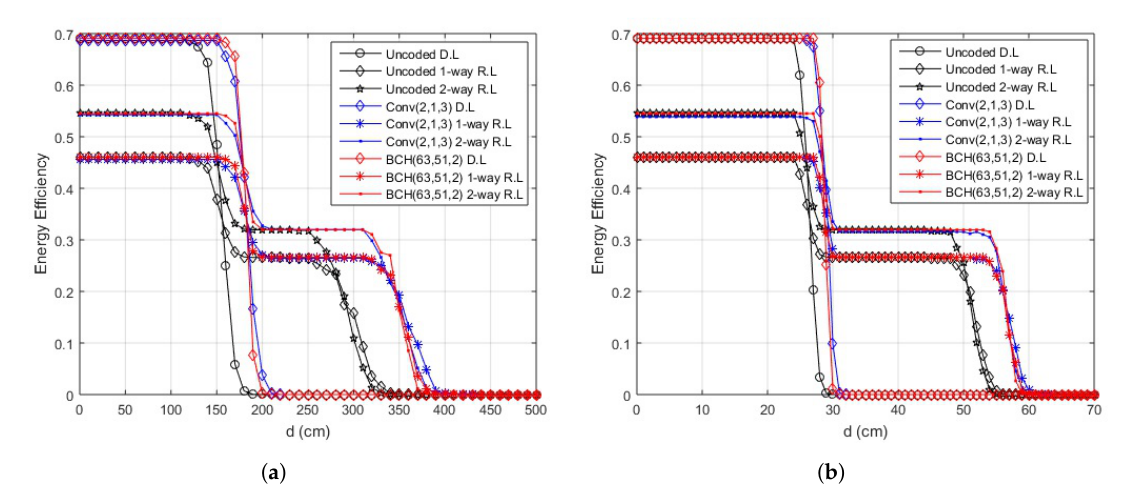
Figure 15. Energy efficiency for JNC coded data, convolutional R = 1/2, BCH t = 2 (on-body communication). ( a ) energy efficiency for JNC coded data, convolutional R = 1/2, BCH t = 2 (on-body LOS communication); ( b ) energy efficiency for JNC coded data, convolutional R = 1/2, BCH t = 2 (on-body NLOS